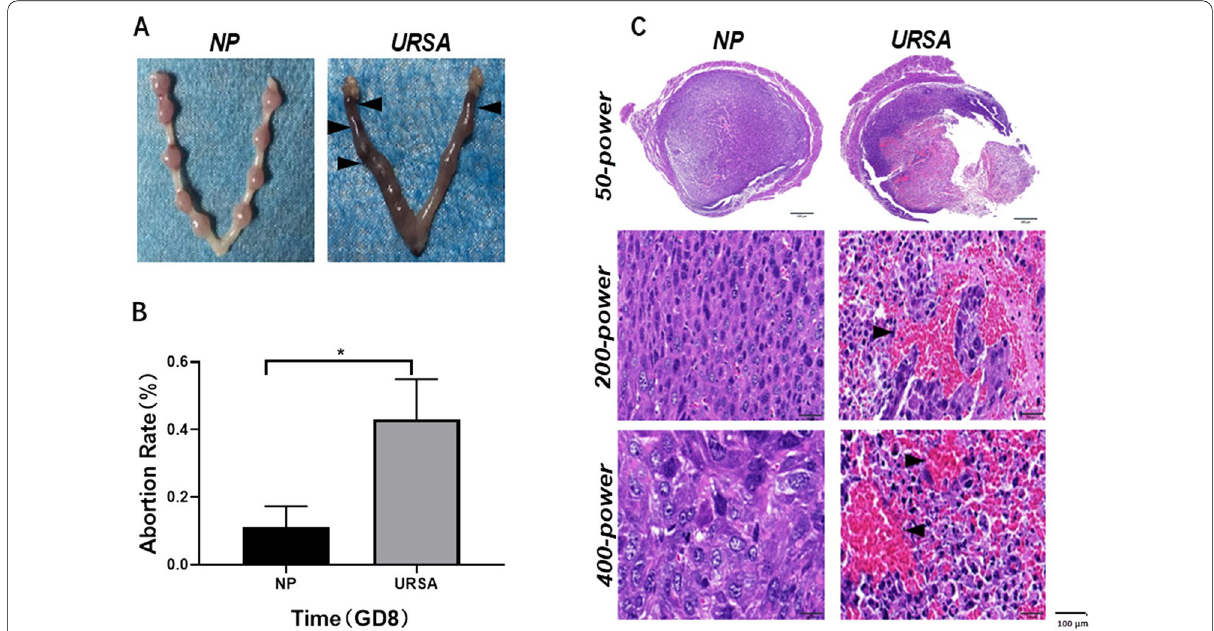
Fig. 1 The histomorphology and abortion rate in NP and URSA groups (mean SD). A On GD8, the uterus of the NP group exhibited normal shape ± with clearly visible implanted embryos. Immature, absorbed, or dead implanted embryos were often found in the URSA group. Arrowheads point to absorbed and necrotic sites. B The abortion rate (mean SEM, %) on GD8 was significantly higher in the URSA group compared to that in the ± NP group. Abortion rate ratio of absorbed and necrotic embryos to the total number of implanted embryos. *Significantly different (p < 0.005) = between null vs. NP. (n 5 in A – B ); C. 50 , 200 , and 400 magnification images of enucleated decidual tissue stained for hematoxylin and eosin = × × × taken after whole tissue scanning. Arrowheads point to pathological form sites. Scale bar, 100 μm. GD8, gestation day 8; NP, normal pregnancy; URSA, unexplained recurrent spontaneous